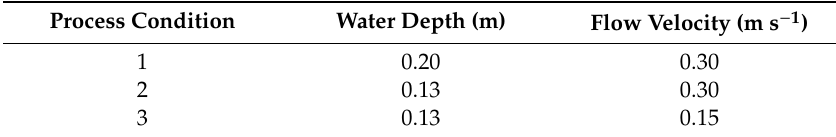
Table 2. Set of process conditions used. Each set of conditions was run in duplicate. Process